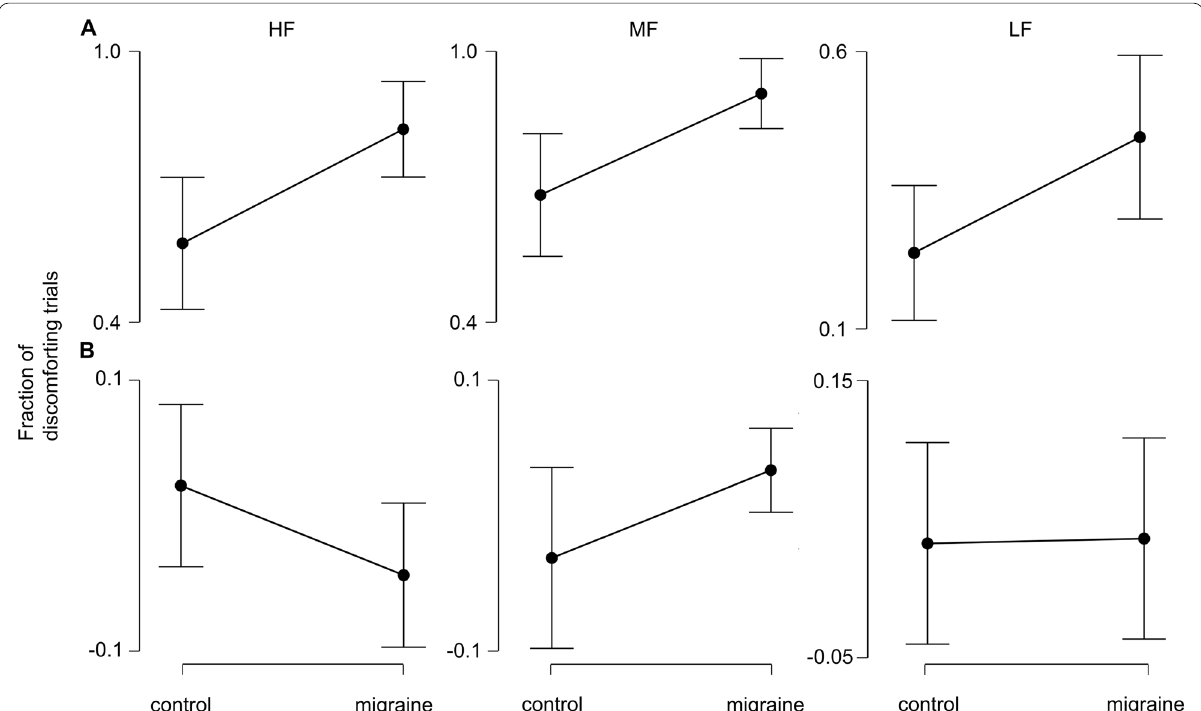
Fig. 2 Fraction of discomforting trials for migraineurs and controls. A The mean fraction (with 95% CI) of discomforting trials for migraine vs. control across 3 conditions. B The mean change (2nd half – 1st half) of fraction (with 95% CI) of discomforting trials for migraine vs. control across 3